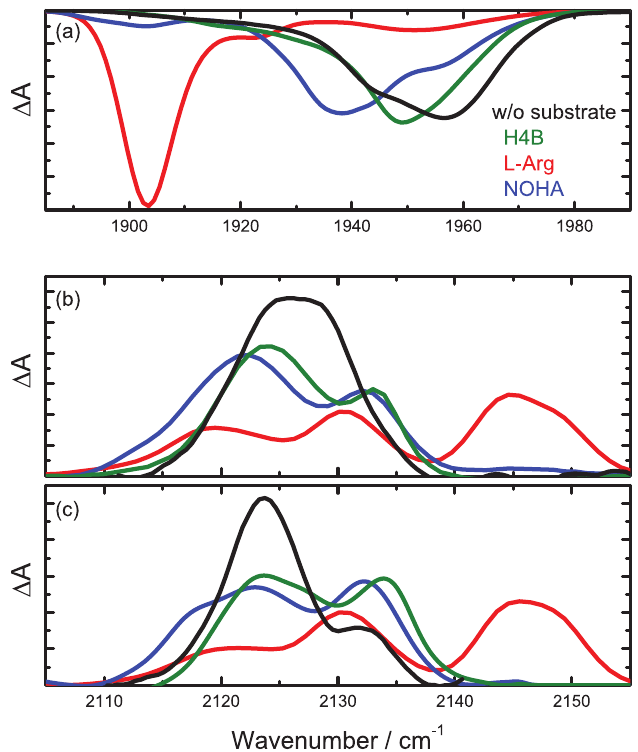
Figure 2. 4-K photolysis difference spectra of iNOS -CO. ( a ) Absorption of the heme-bound CO. ( b ) Photoproduct bands obtained after oxy 10-s illumination at 4 K. ( c ) Photoproduct bands obtained after constant illumination during slow cooling from 160 to 4